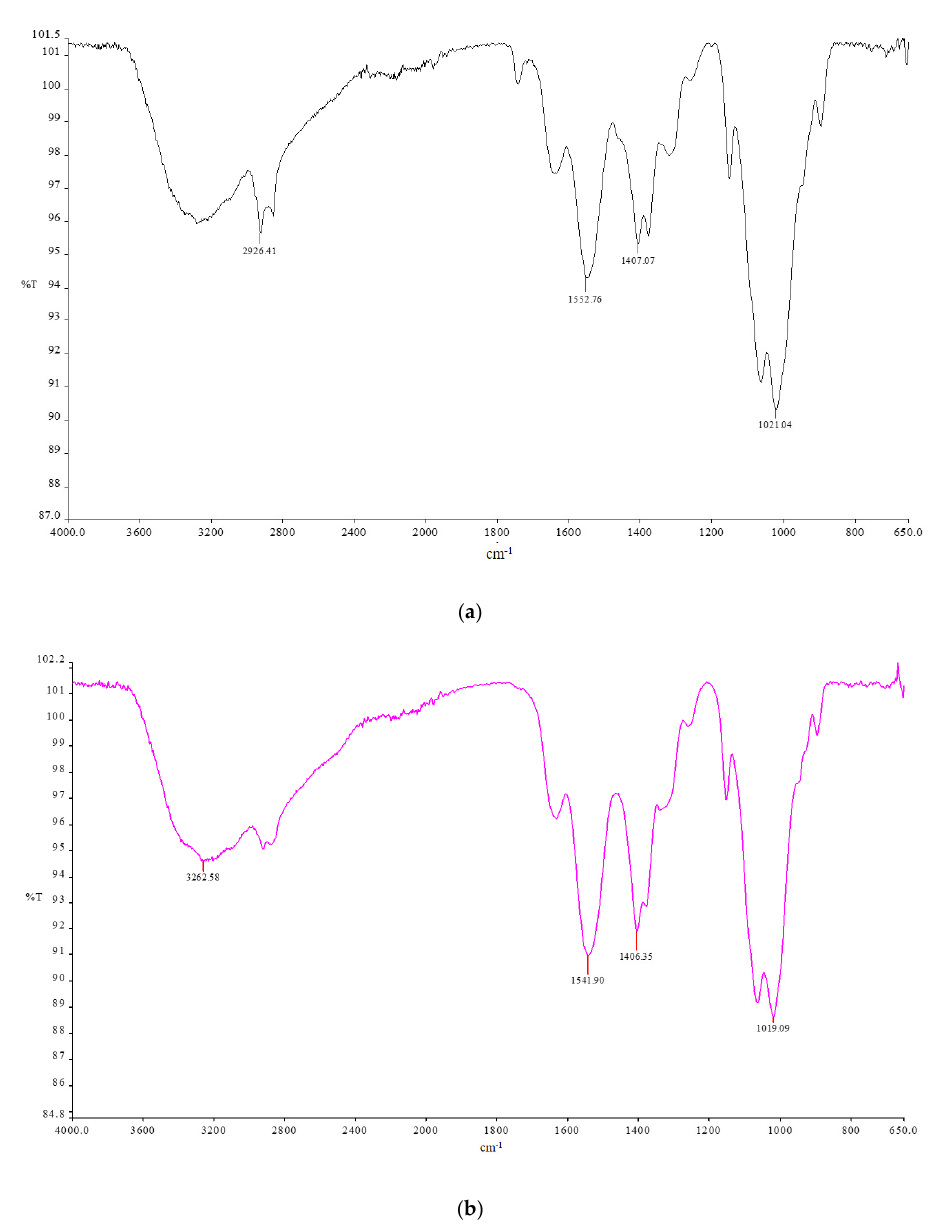
Figure 5. FT-IR of membrane based on chitosan ( a ), chitosan + CsACC ( b ).